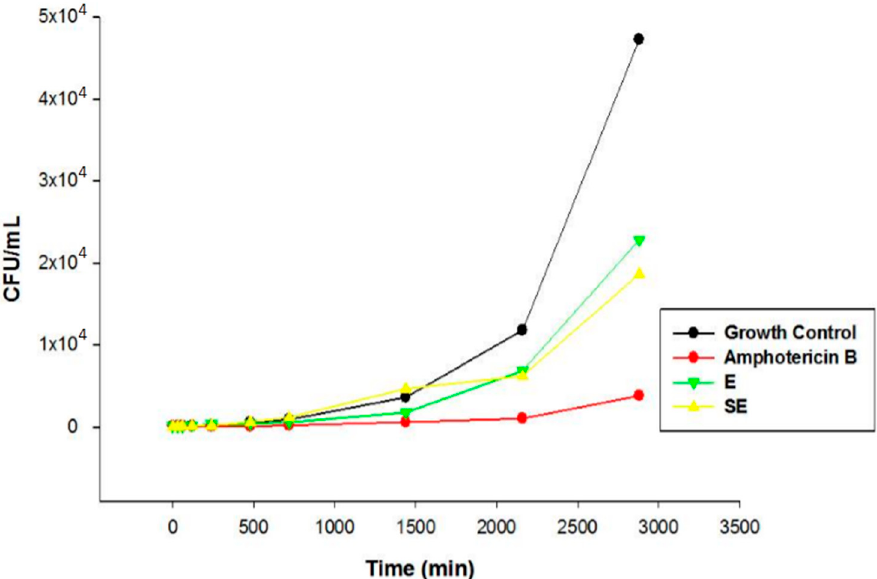
Figure 10. Time kill assay of CAV3 strain. Legend: E = Extract solution (without incorporation); SE = Formulation with extract.